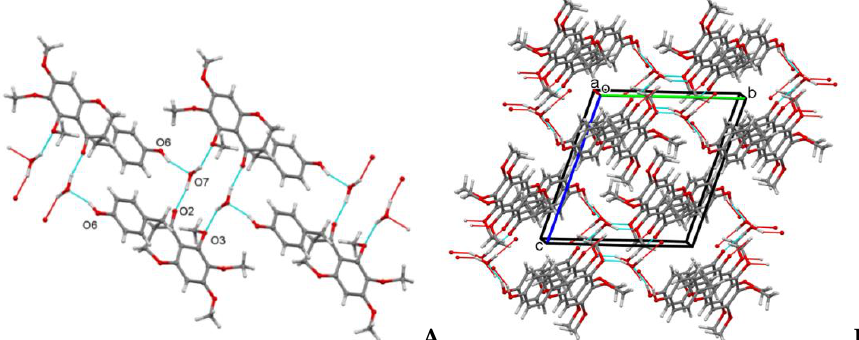
Figure 3. ( A ) Details of hydrogen bonding pattern in compound 1 . ( B ) Perspective view of the crystal packing of compound 1 with hydrogen bond pattern drawn as cyan and red lines. Ball-and-stick style.